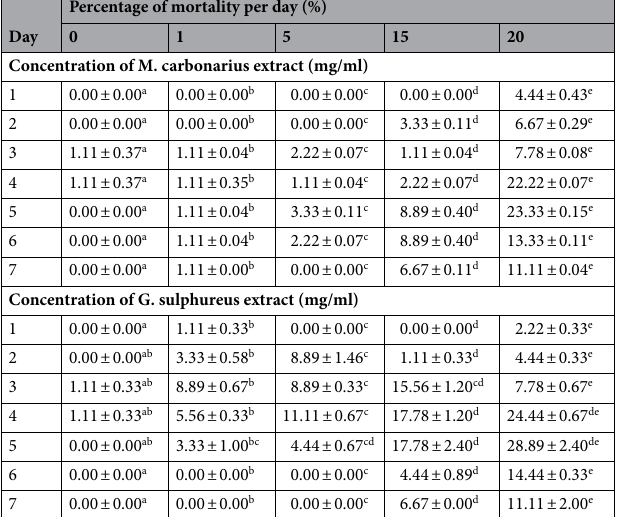
Table 6. Mean mortality percentage for seven days using Macrotermes carbonarius and Globitermes sulphureus extracts against Macrotermes gilvus at five different concentrations. Different letters in the same row indicate a significant difference ( p < 0.05, Duncan’s test).